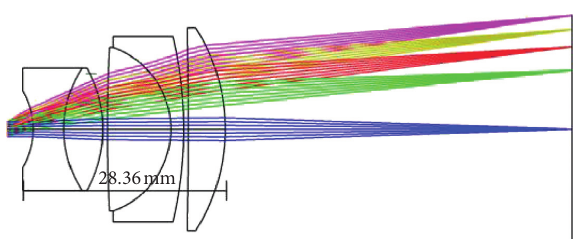
Figure 4: Microlens light